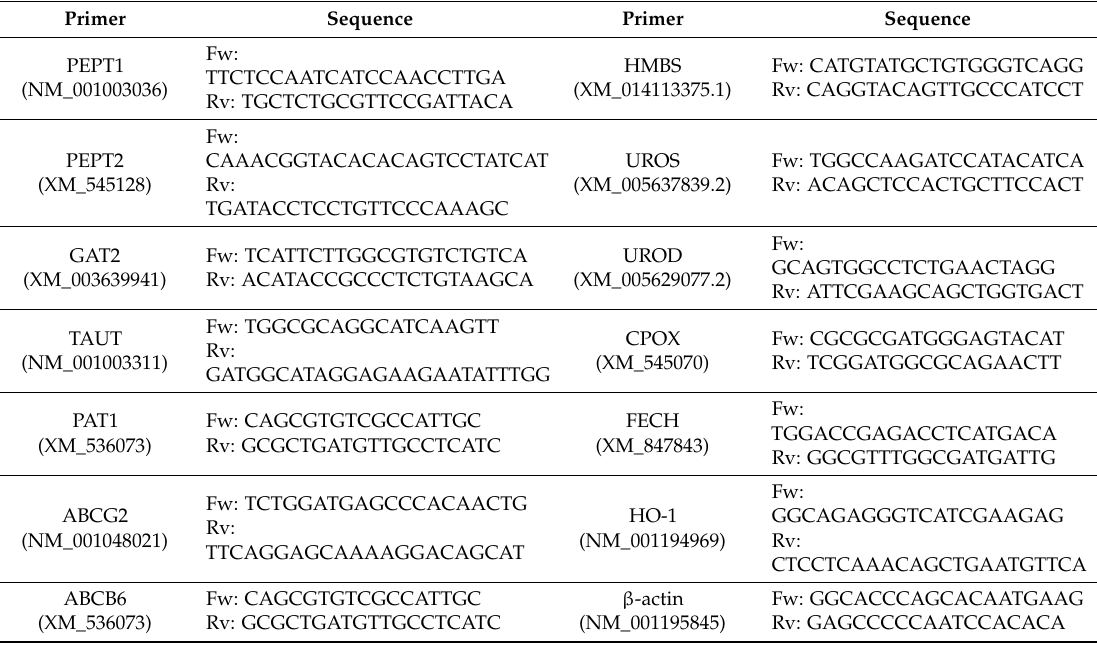
Table 6. Specific primers for each